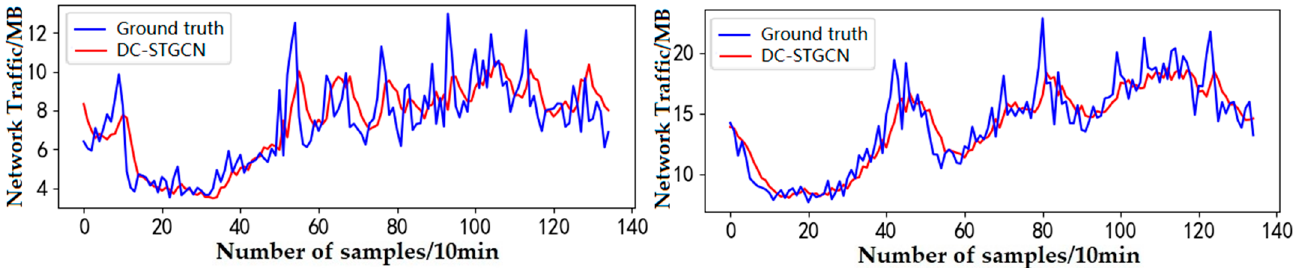
Figure 13. Visualization of one-step prediction results for the holiday dataset.